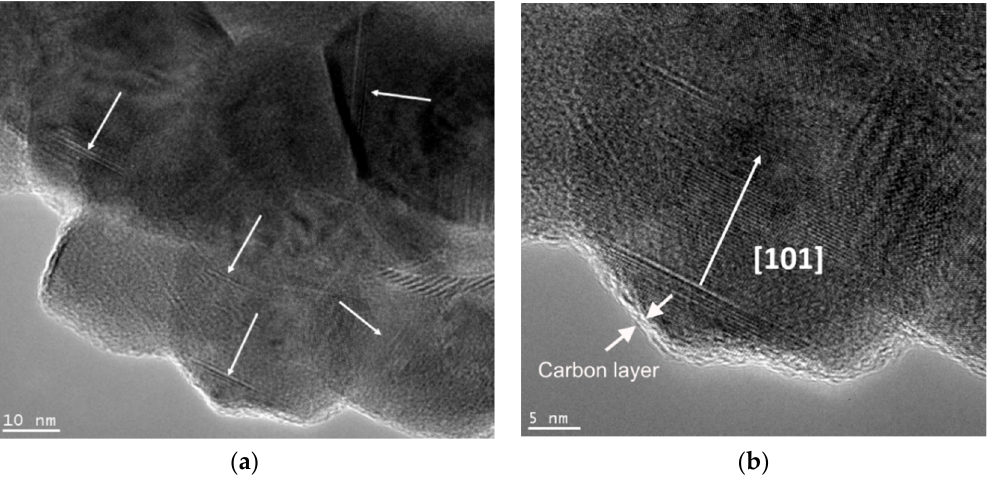
Figure 2. HRTEM images of perovskite particles with planar defects ( a ) and crystal lattice of perovskite containing defects in the direction of the planes (101) ( b ).